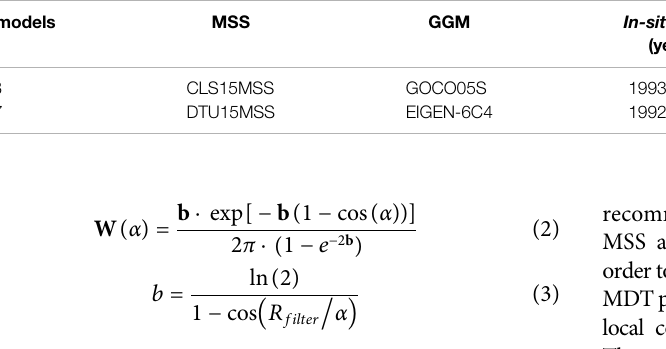
TABLE 2 | | The summary of the MDT